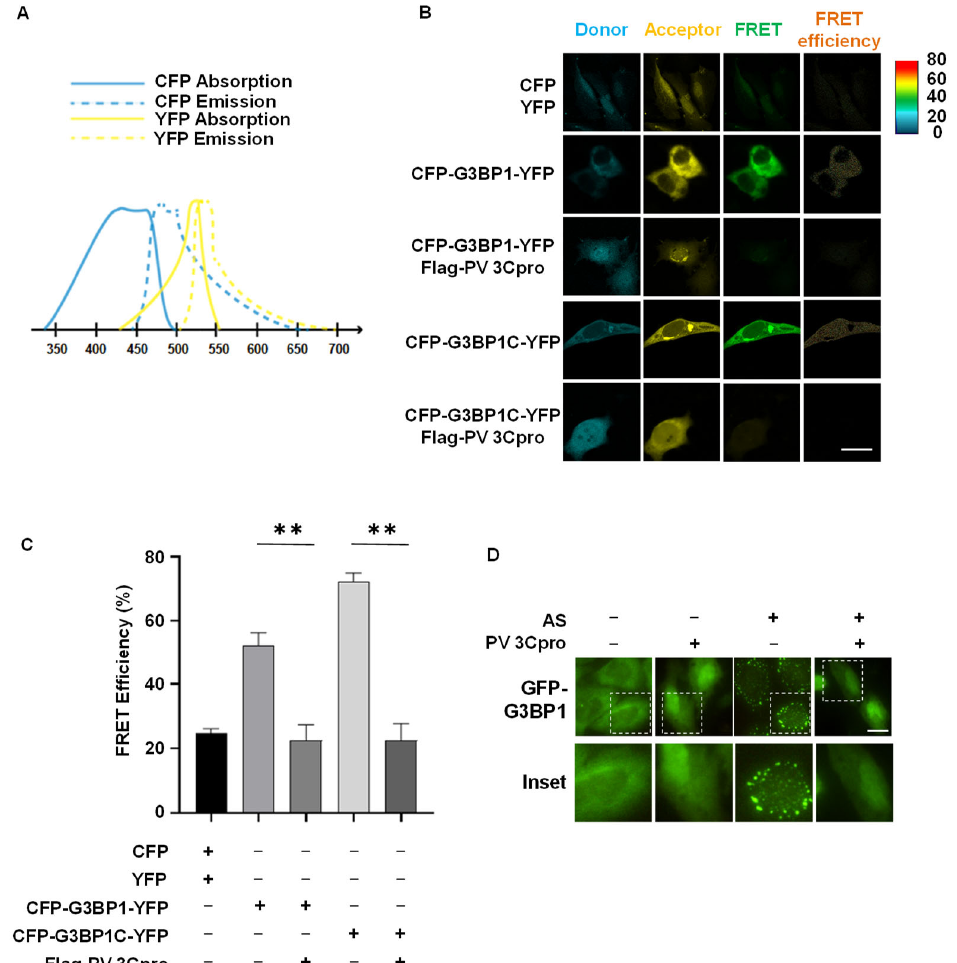
Figure 3. Monitoring PV 3Cpro activity in living cells via FRET and SG dual-based system. ( A ) Ab- sorption spectrum of CFP (blue solid line) and emission spectra of CFP (blue dotted line), and absorption spectrum of YFP (yellow solid line) and emission spectra of YFP (yellow dotted line). ( B ) HeLa cells were transfected with CFP-G3BP1-YFP or CFP-G3BP1C-YFP together with Flag-PV 3Cpro or vectors followed by FRET using the FRET module of the Zeiss LSM880 confocal microscopy system. Scale bar: 20 µ m. ( C ) Statistical analysis of the FRET efficiency shown in panel ( B ). Data are shown as the mean ± SD ( n = 3). Statistics: Student’s t -test (**, p < 0.01). ( D ) HeLa cells stably overexpressing GFP-G3BP1 were transfected with Flag-PV 3Cpro or vectors, and were untreated or treated with 0.5 mM AS for 45 min followed by imaging of living cells. Scale bars: 20 µ